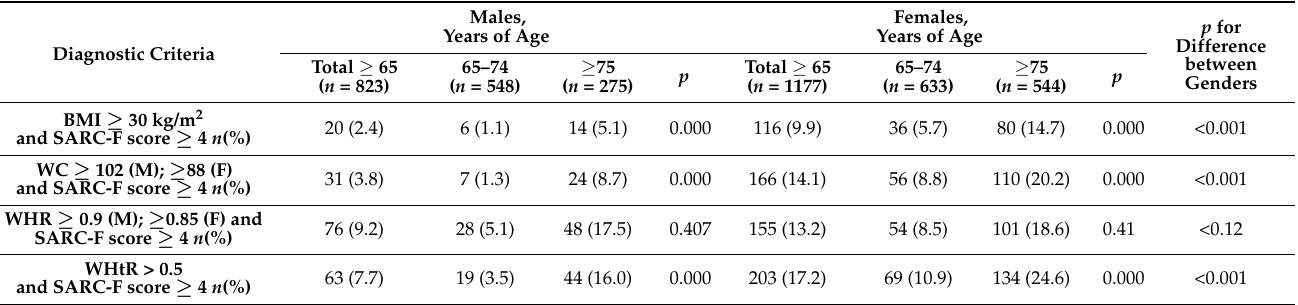
Table 4. Sarcopenic obesity risk